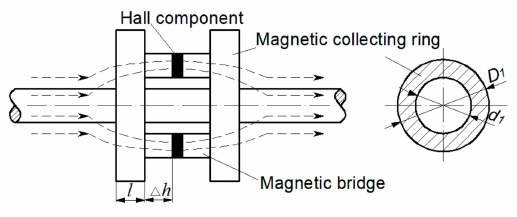
Figure 9. Structure and dimensions of the magnetic